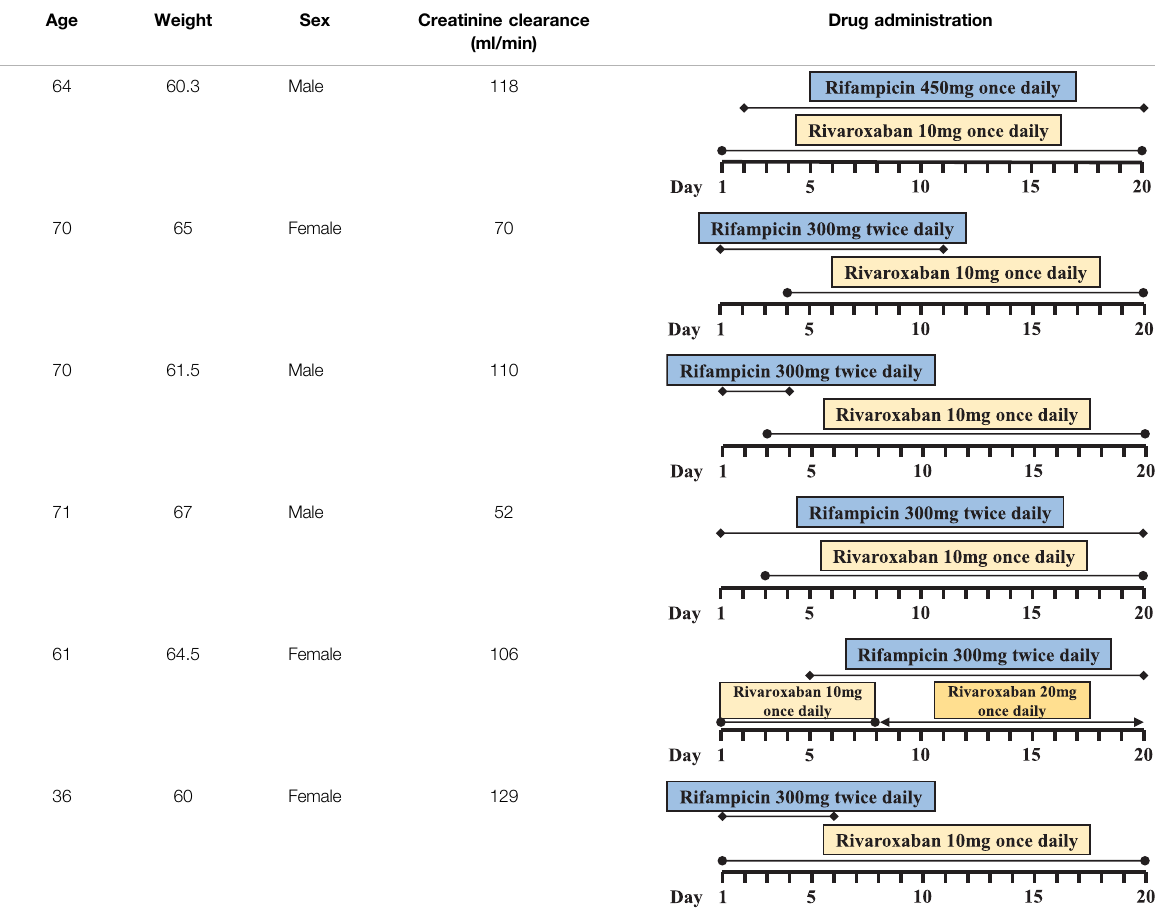
TABLE 1 | Patients ’ physical condition and dosing regimens of rivaroxaban and rifampin. case